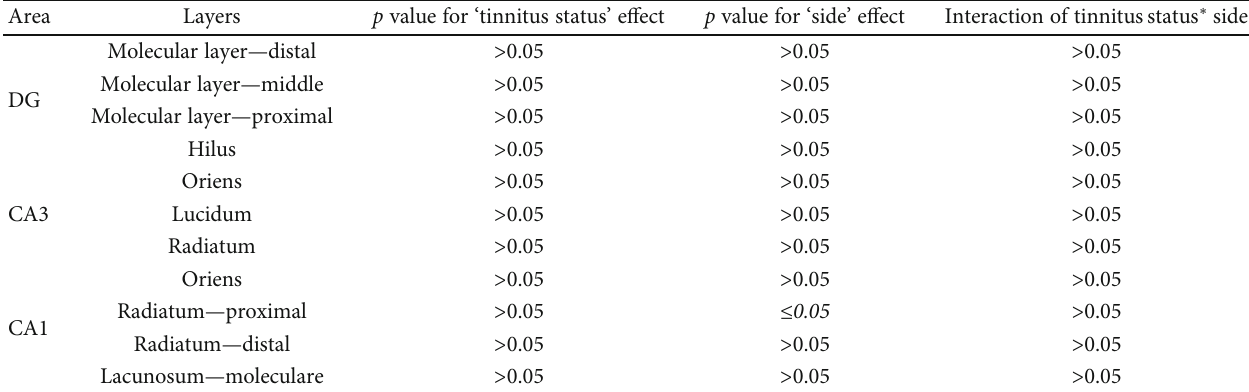
Table 2: Animals with tinnitus and animals without tinnitus demonstrated similar VGLUT-1 labeling in all layers and no di ff erence between both sides, analyzed by two-way